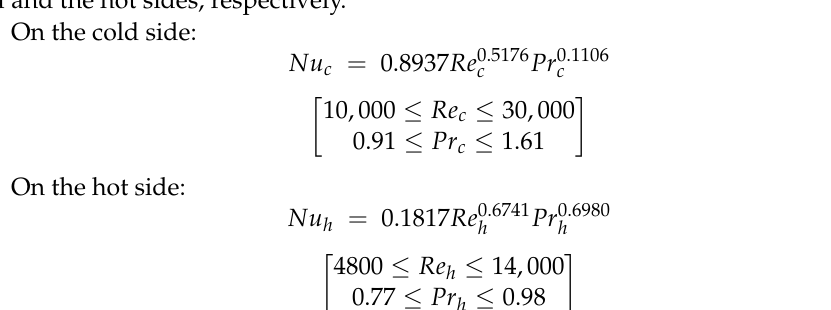
Figure 6 reflects the difference between the correlations and the experimental results.